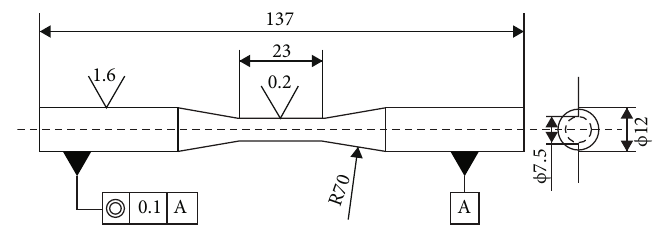
Figure 4: Geometry of 30NiCrMoV12 alloy steel specimens (dimensions in mm). Table 1: Experimentally obtained and corresponding theoretical remaining life values predicted by the Miner, Kwo fi e, and proposed new model for the 30NiCrMoV12 alloy steel under two-level cyclic